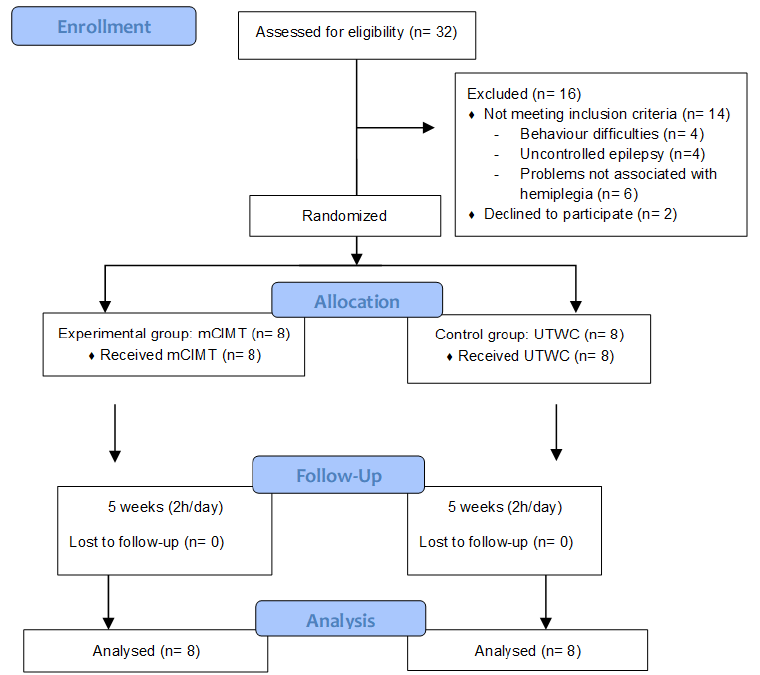
Figure 3. Consort flowchart. Allocation of the sample, therapies performed and analysis. Fifty percent of the participants were males and the other 50% were females and 100% of them were diagnosed with congenital hemiplegia (perinatal stroke). Of the entire sample, 62.50% had left hemiplegia, with the involvement of the right half of the body being less representative (37.50%), and 56.25% were classified as Manual Ability Classification System (MACS) level II. All the children had infantile hemiplegia due to perinatal stroke (Table